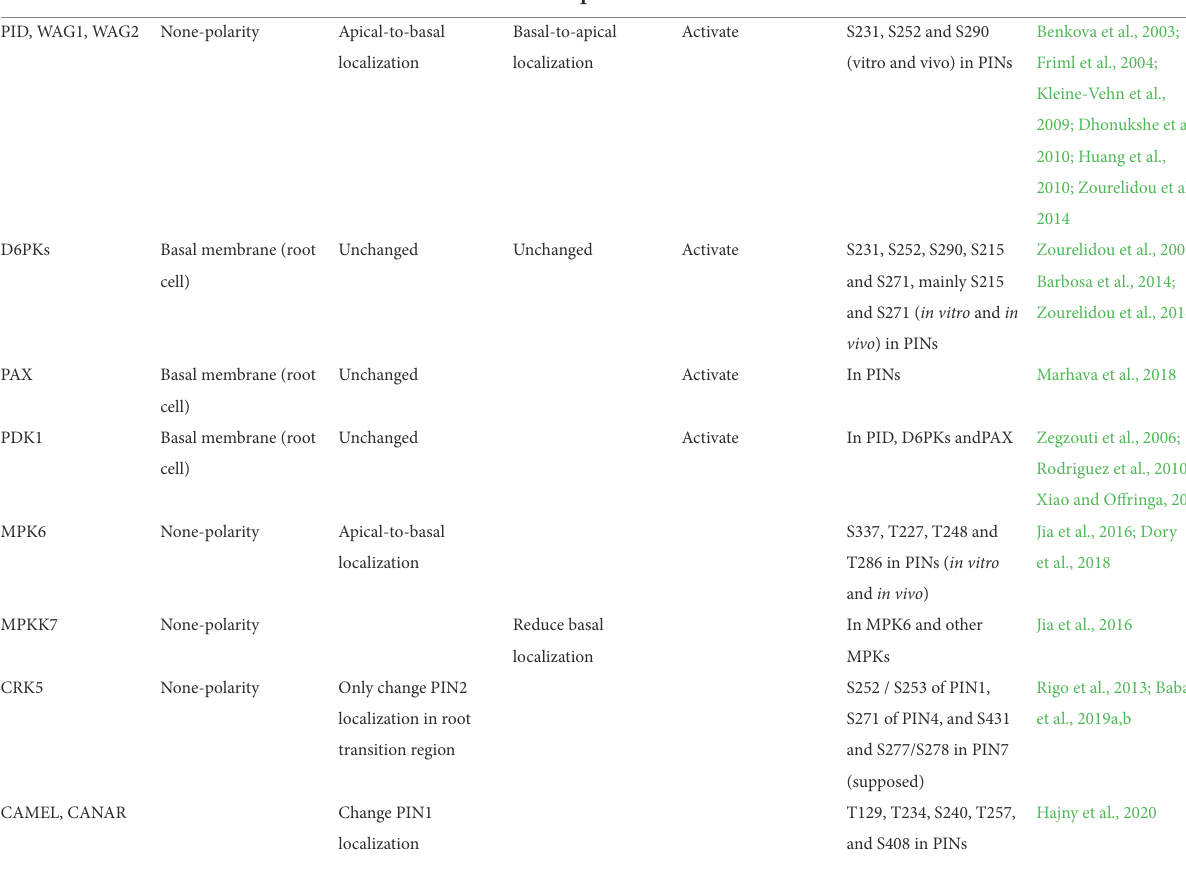
TABLE 4 Kinases that may affect PIN polarity.